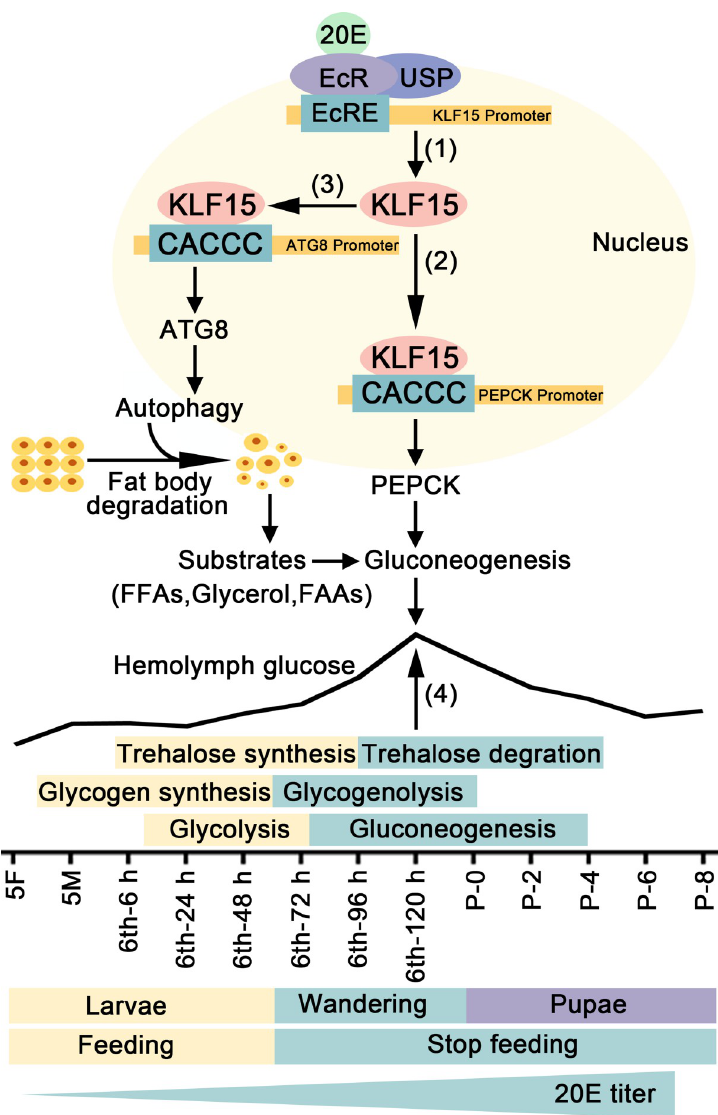
Fig 9. A diagram illustrating 20E regulates glycometabolism reprogramming, autophagy, and apoptosis via KLF15. 20E promotes the expression of Klf15 via nuclear receptors (1). By binding to the KLF bs, KLF15 promotes the transcription of Pepck , a crucial enzyme in gluconeogenesis (2). KLF15 increases the transcription of the autophagy- related gene Atg8 to induce autophagy (3), thereby providing substrates for gluconeogenesis. The increase of glucose during metamorphosis is due to trehalose and glycogen degradation, glycolysis inhibition, and gluconeogenesis (4).